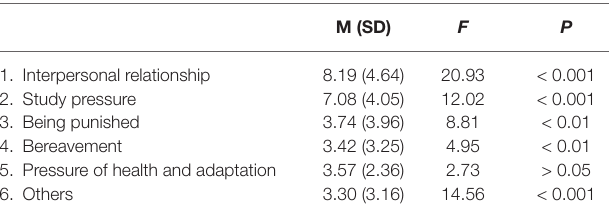
TABLE 2 | One-way ANOVA of Adolescents Self-Rating Life Events Checklist. M (SD) F P 1. Interpersonal